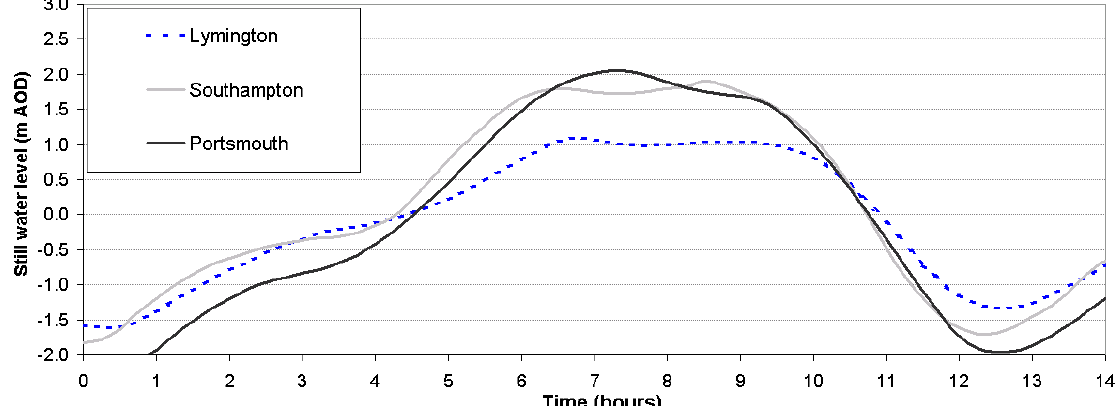
Figure 2. Water level time-series; recorded at three locations across the Solent (refer to Figure 1) during a typical spring